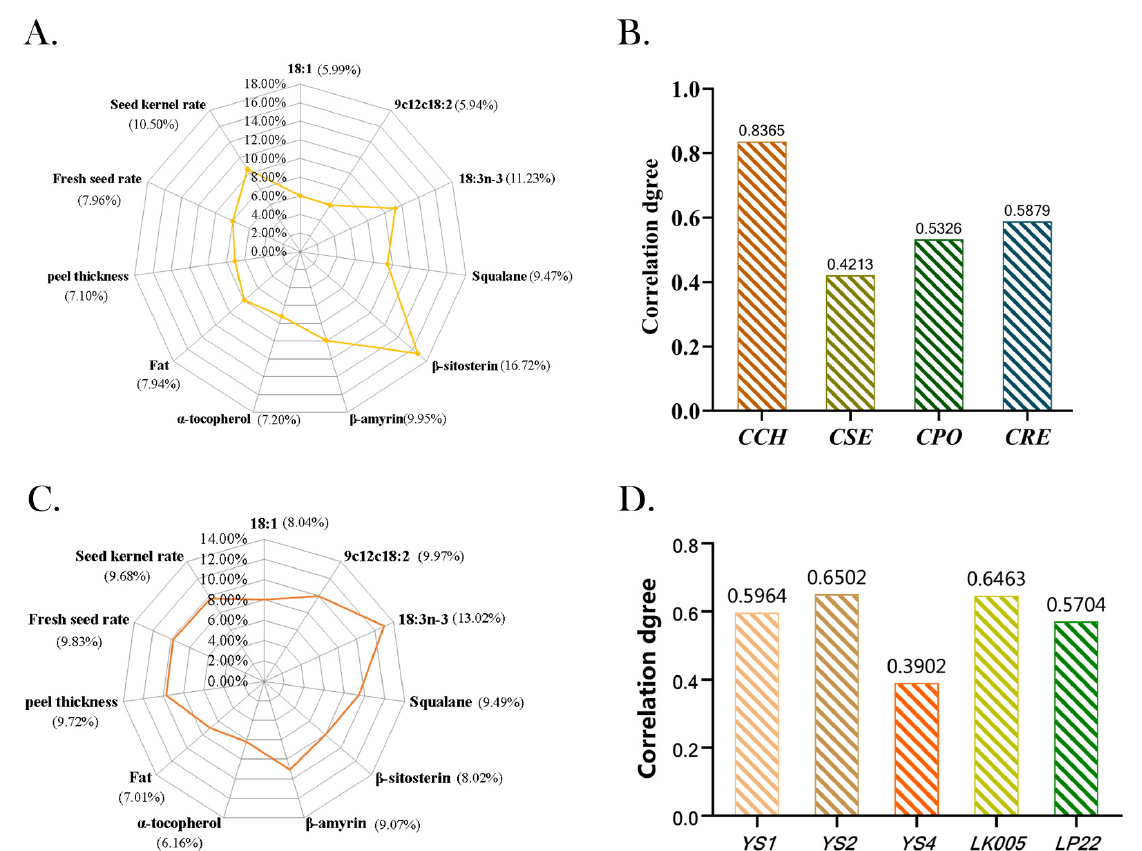
Figure 2. ( A ). The weights of nutrients in four ROC oils calculated according to the gray correlation coefficient method. ( B ). Correlation degrees of four ROC oils. ( C ). The weights of nutrients in five clones of Camellia chekiangoleosa Hu. oil, calculated according to the gray correlation coefficient method. ( D ). Correlation degree of five clones of camellia chekiangoleosa Hu. oil. YS-1, YS-2, YS-4, LK005 and LP22 all represent clone varieties of Camellia chekiangoleosa Hu., and CPO , CSE and CRE fruit materials were mixed samples of 5